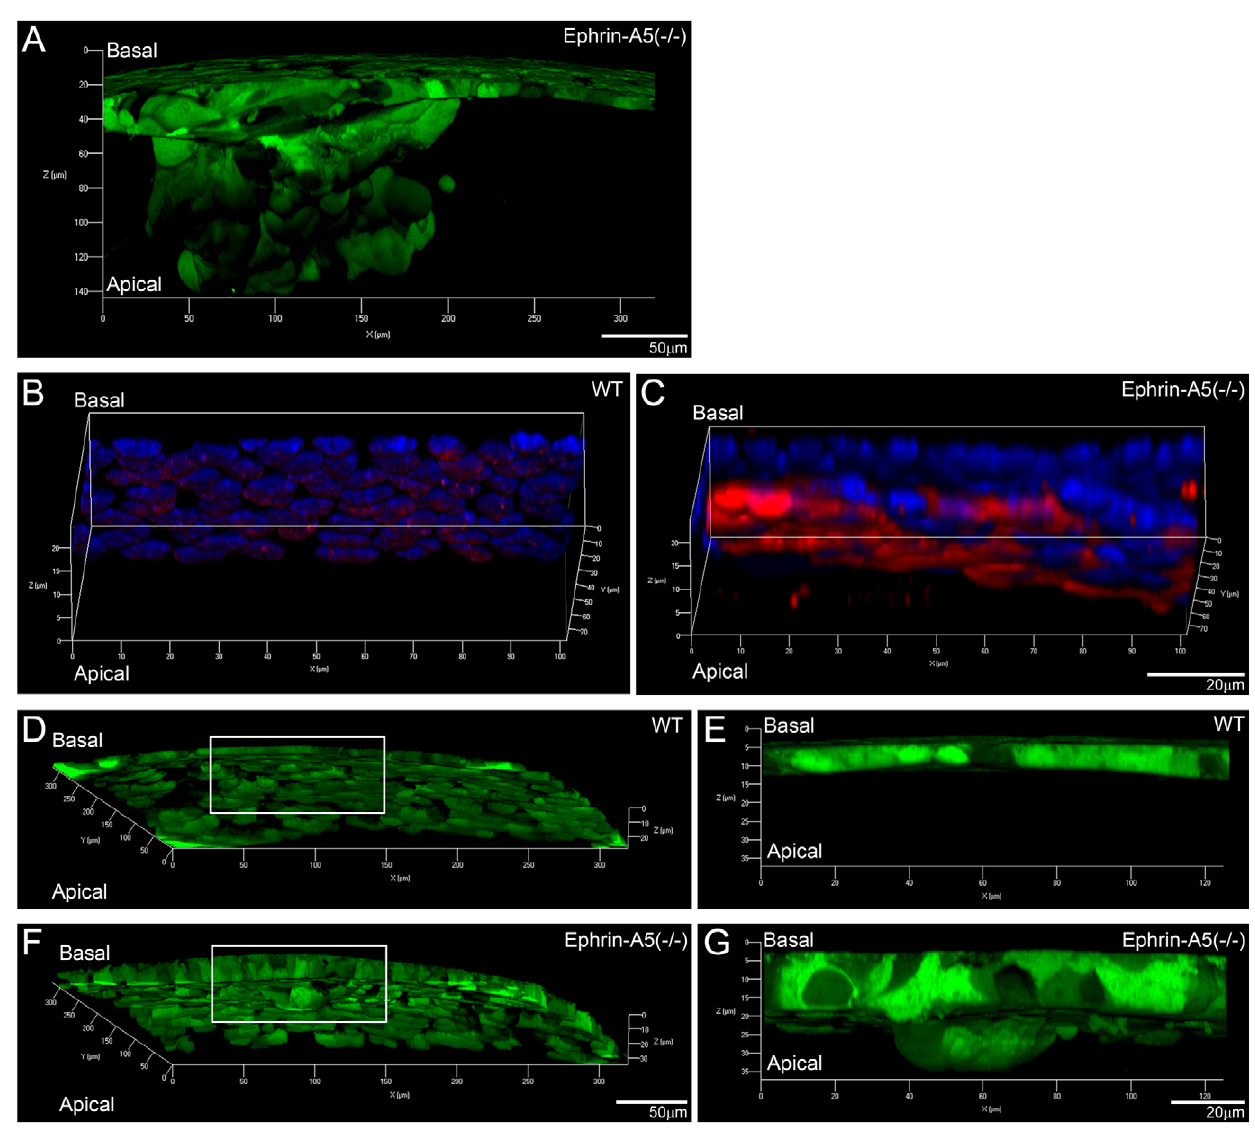
Figure 3. Characterization of lens anterior polar regions in GFP + WT and ephrin-A5(-/-) lenses. Three-dimensional reconstruction of a P21 GFP + ephrin-A5(-/-) lens reveals a large cluster of aberrant cells underneath anterior epithelial cells (A). Scale bar, 50 m m. Immunostaining of a -SMA (red) in anterior epithelial cells from lens capsule flat mounts of P21 WT (B) and ephrin-A5(-/-) lenses (C). Only ephrin-A5 (-/-) anterior epithelial cells that are abnormally clustered in the fiber cell layer are obviously positive for a -SMA. Scale bar, 20 m m. Three-dimensional reconstruction of the anterior polar region of P14 GFP + WT (D) and ephrin-A5(-/-) lenses (F). Scale bar, 50 m m. Enlarged views of anterior epithelial cells in D and F are the boxed areas in panels E and G. Scale bar, 20 m